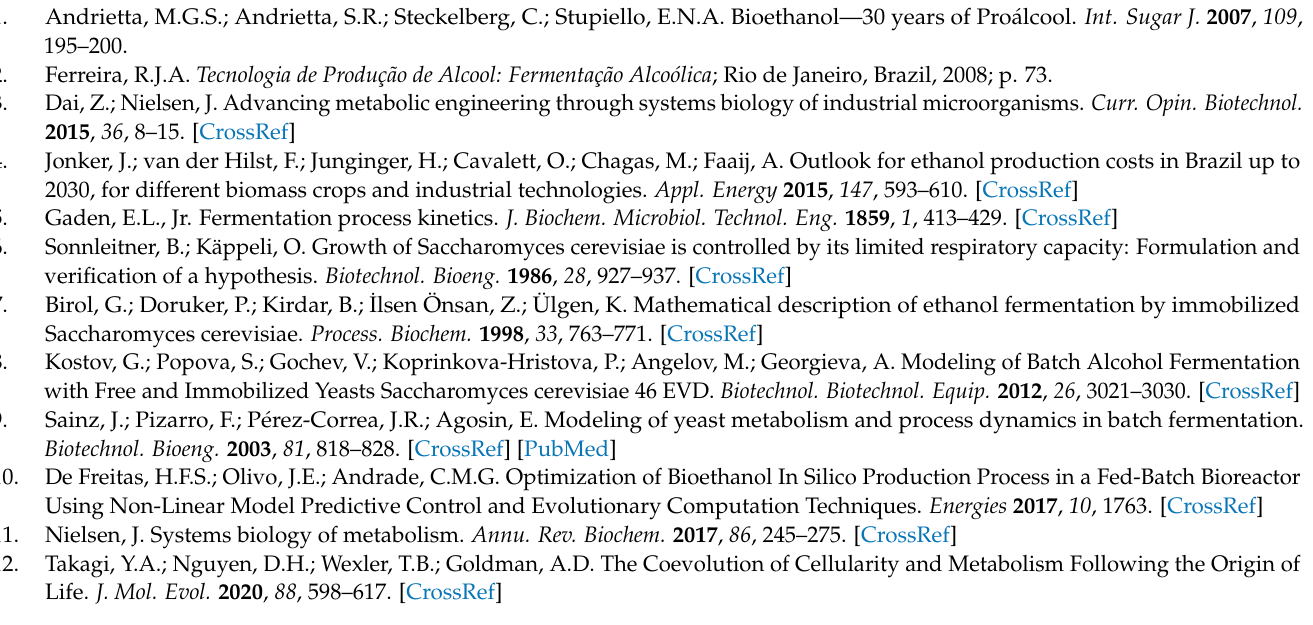
) of the SR and CR s